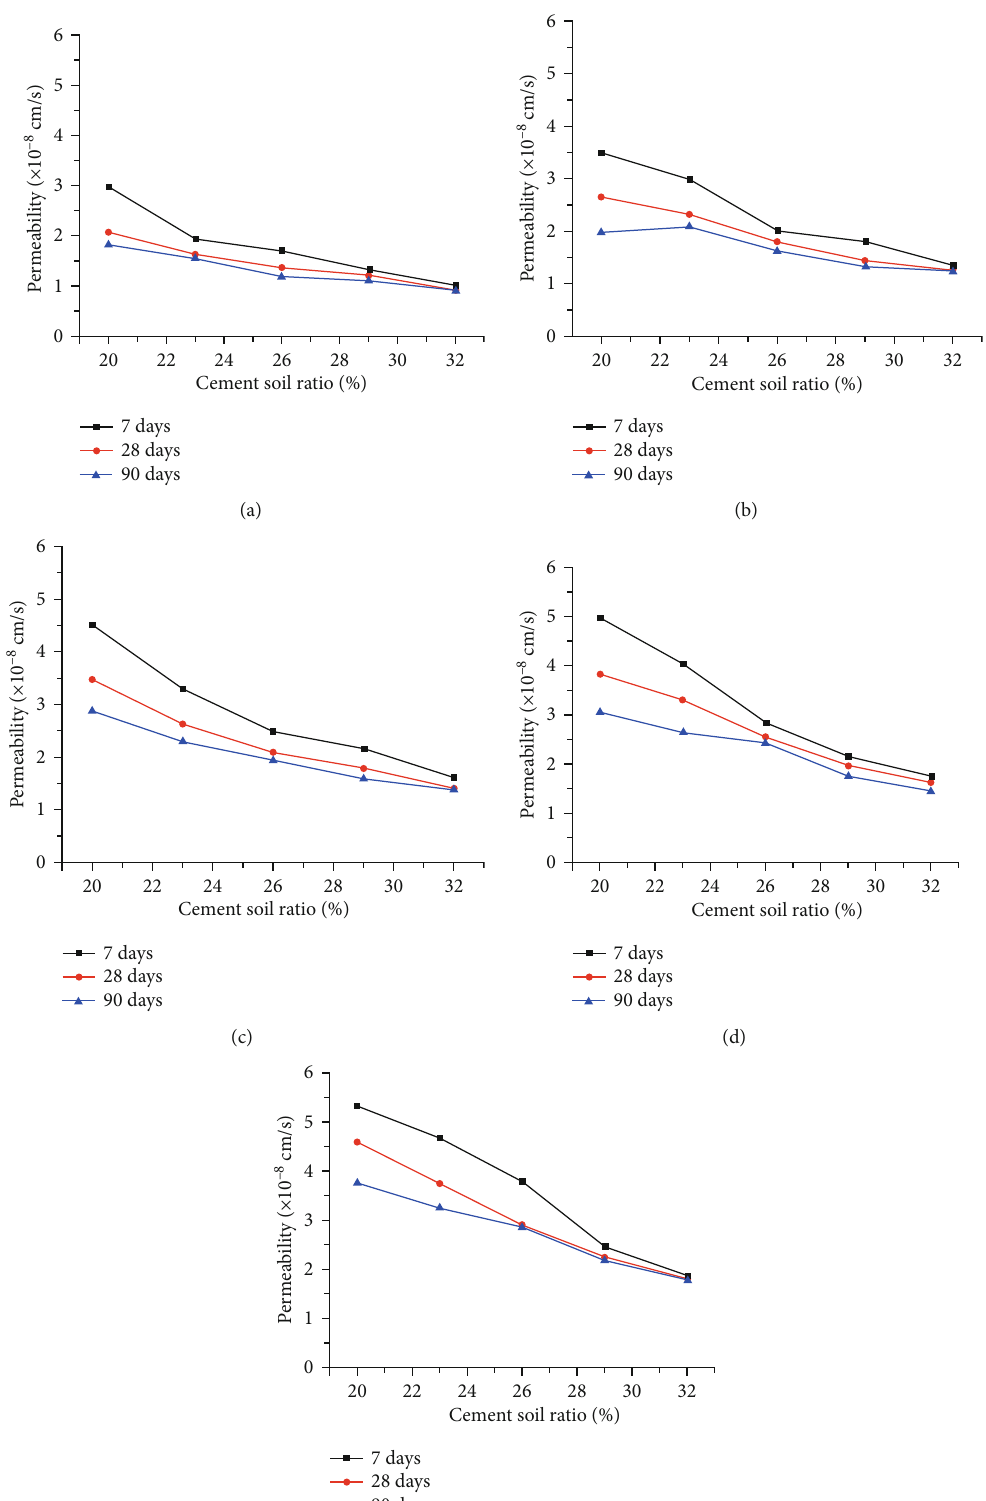
Figure 9: Curve of permeability with cement soil ratio. (a) Moisture content 28%. (b) Moisture content 33%. (c) Moisture content 385. (d) Moisture content 43%. (e) Moisture content